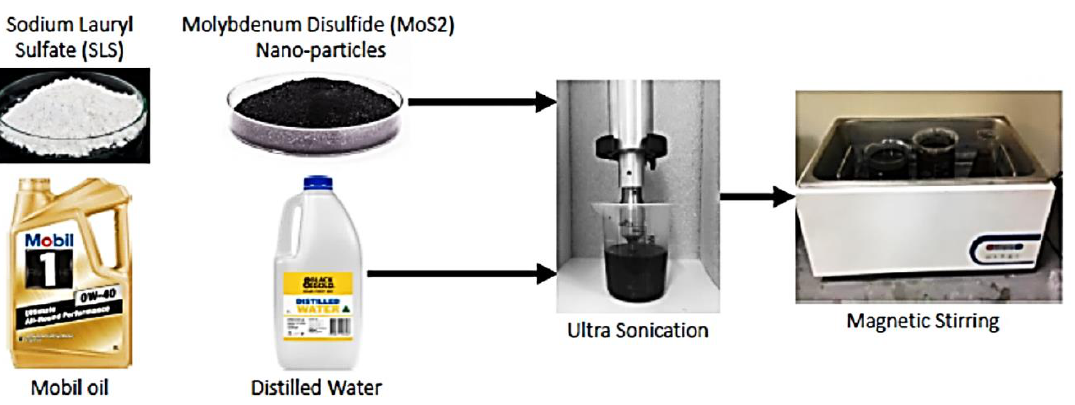
Figure 3. Nano fluid preparation mechanism.